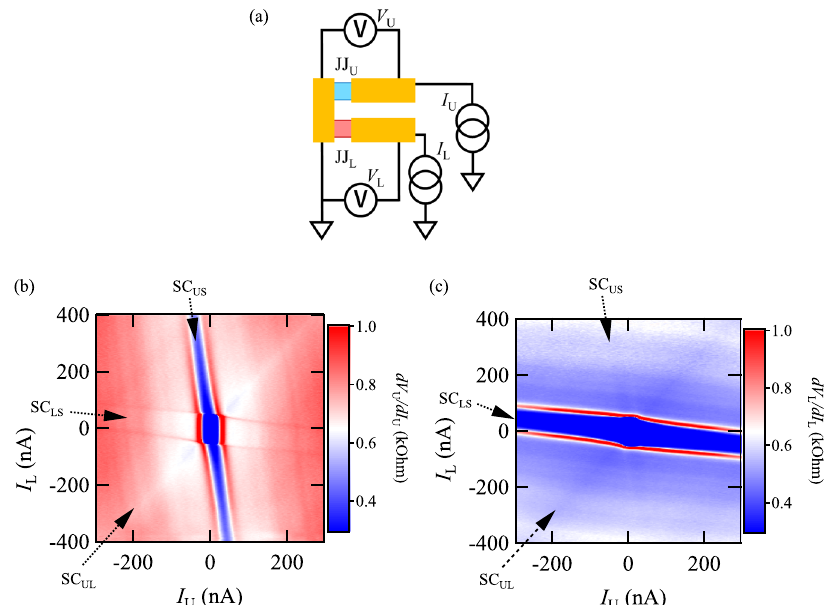
Fig. 2 Three-terminal measurement of the two coupled Josephson junctions on the double nanowire. a Shows a schematic of the electrical circuit used for measurement of sample A. b , c show the differential resistances of JJU and JJL, respectively, as a function of I U and I L , measured simultaneously. The supercurrent fl ows in both JJs in the central blue regions of − 30 nA < I U < 30 nA and − 60 nA < I L < 60 nA. In the regions arranged with SC US , SC LS , and SC UL extending outward from the central blue supercurrent region, the local supercurrent remains between a pair of the two SC electrodes with the dissipative current in the other